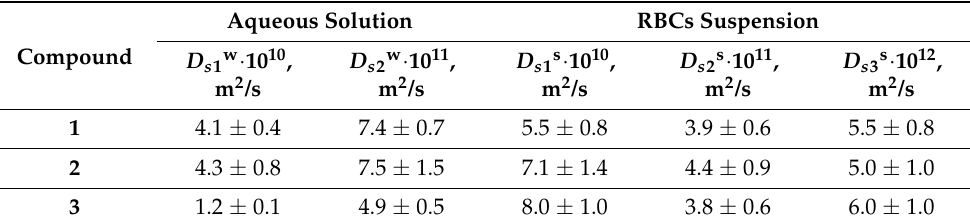
Table 12. Self-diffusion coefficients of WSFD molecules in aqueous solutions and RBCs suspension.